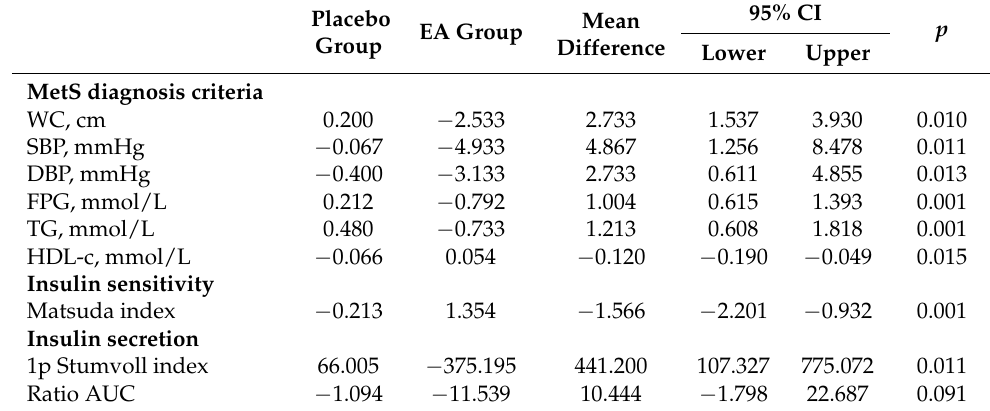
Table 4. Intergroup comparison at the end of the intervention. Difference in means of